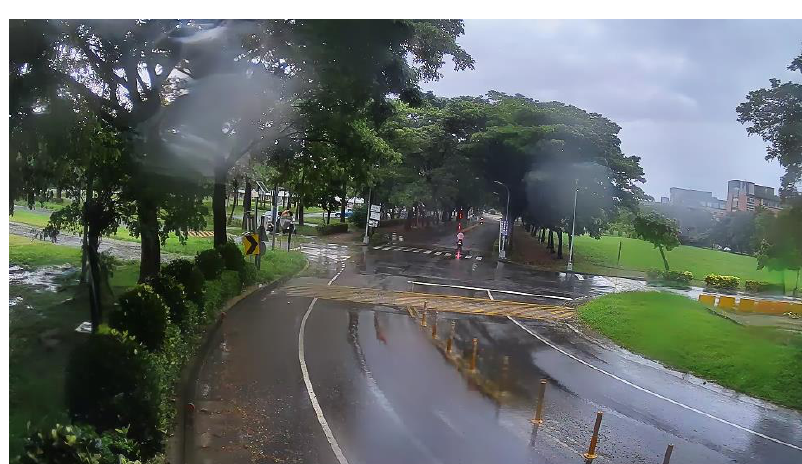
Figure 21. Rainy scene: correction result.